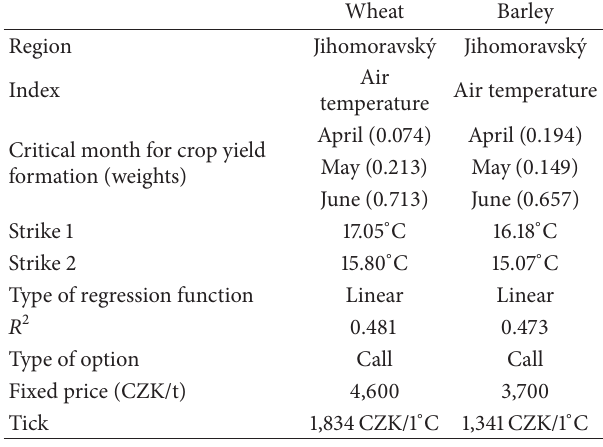
Table 4: Result of Anderson-Darling test of index 𝑇3 for wheat and barley.